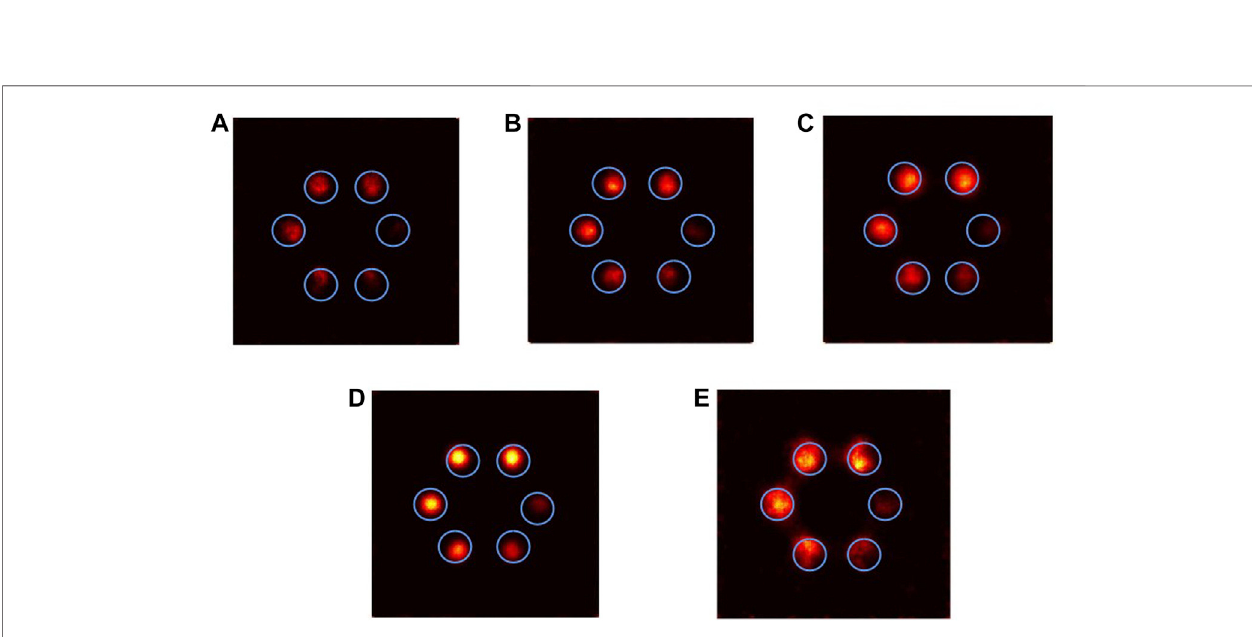
FIGURE 4 | ML-EM algorithm reconstructed images of different contrast agents (iterating 10 times): (A) Pt, (B) Bi, (C) Gd, (D) Ru, and (E) Au.